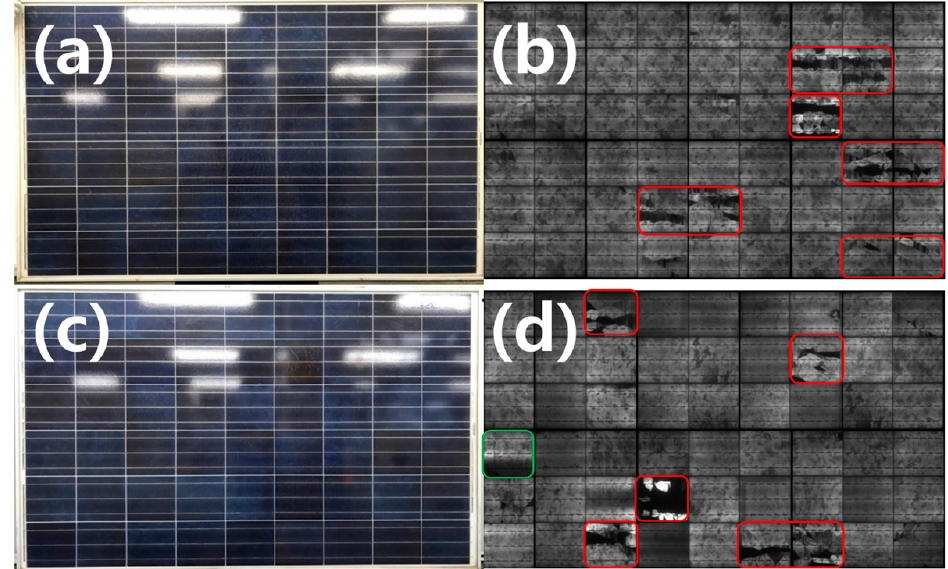
Figure 1. Module appearance and EL images with degraded power output due to cell breakage. ( a ) is the appearance of 190 A, ( b ) is the EL image of 190 A, ( c ) is the appearance of B, and finally ( d ) is the EL image of 190 B.